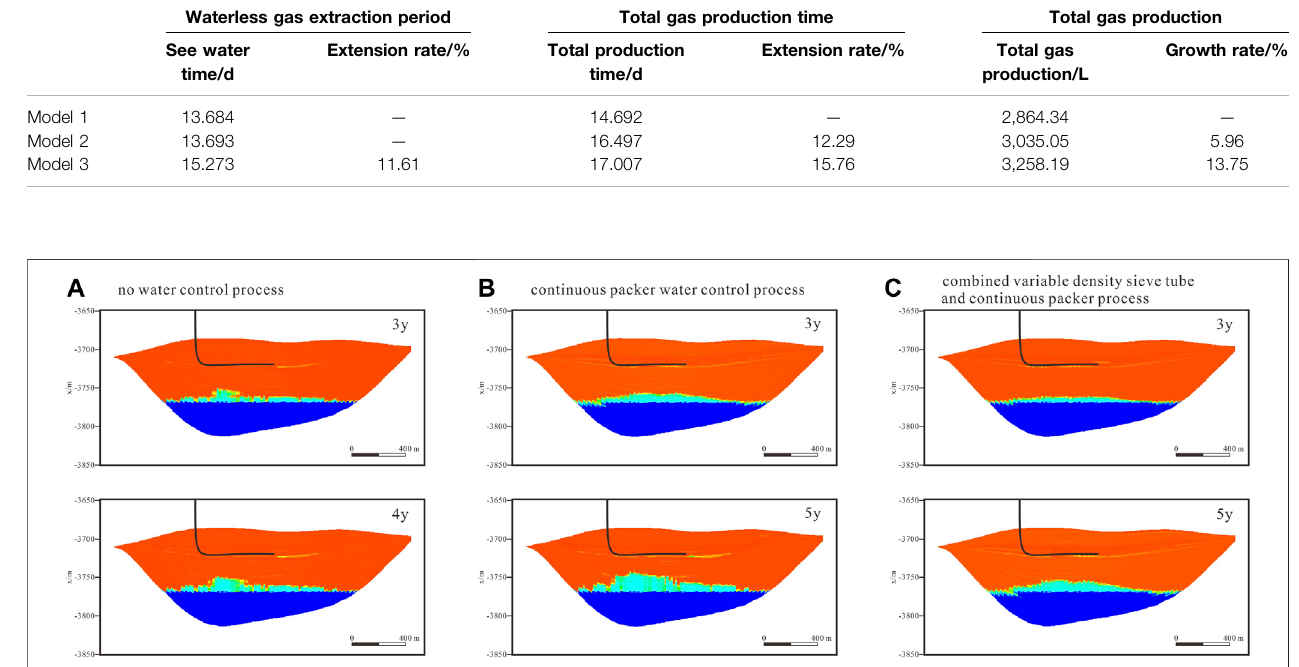
Frontiers in Earth Science |